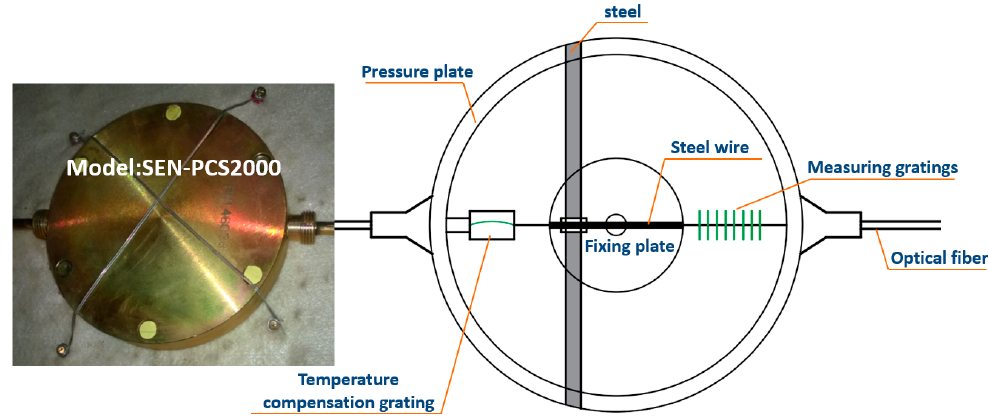
Figure 12. Model and basic structure of pressure cells.